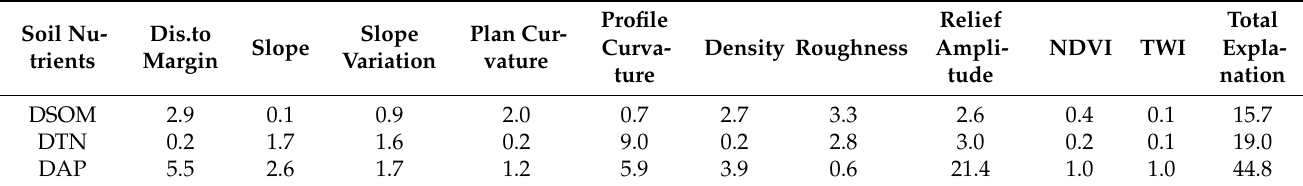
Table 3. The explanations of environmental factors on soil nutrients loss based on